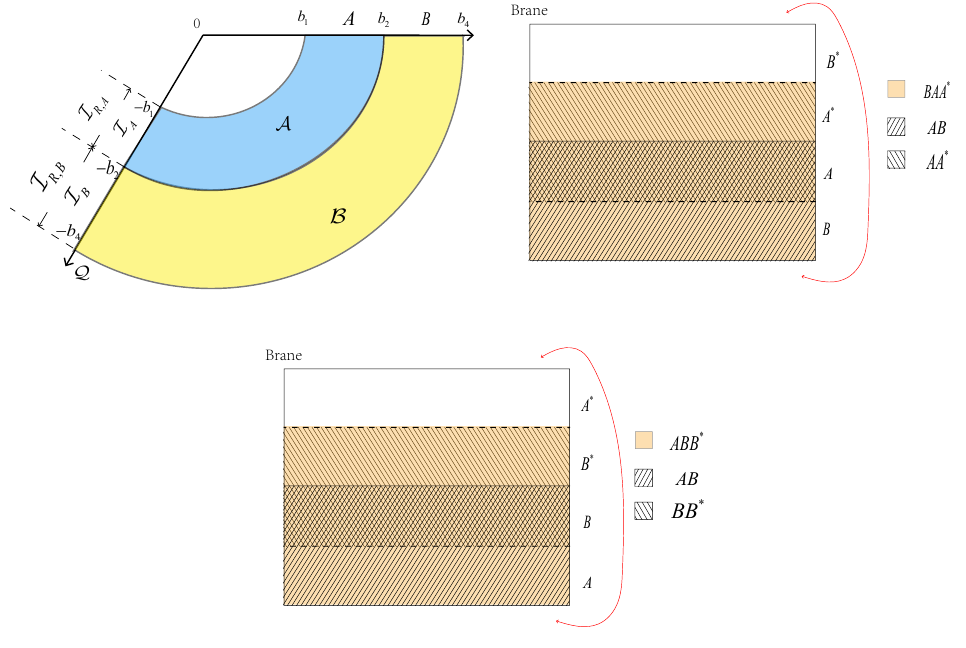
Figure 9 . Phase-A1. In this phase, the entanglement islands of A and B are identically their reflected